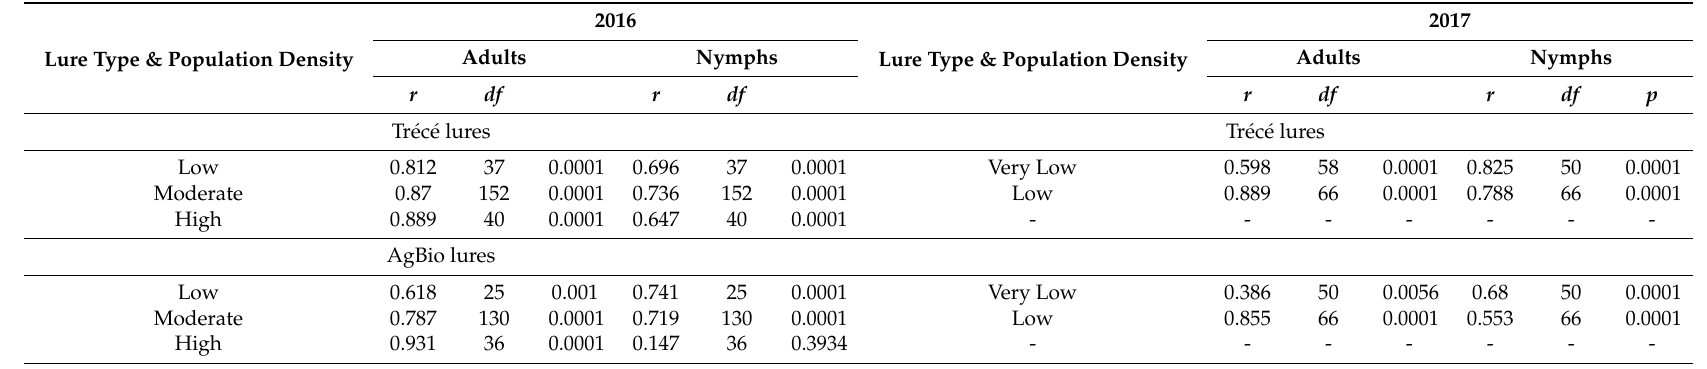
Table 3. Pearson correlation coefficients ( α = 0.05) between captures of H. halys using low and high loading rates of Tr é c é and AgBio lures on clear sticky traps in 2016 and